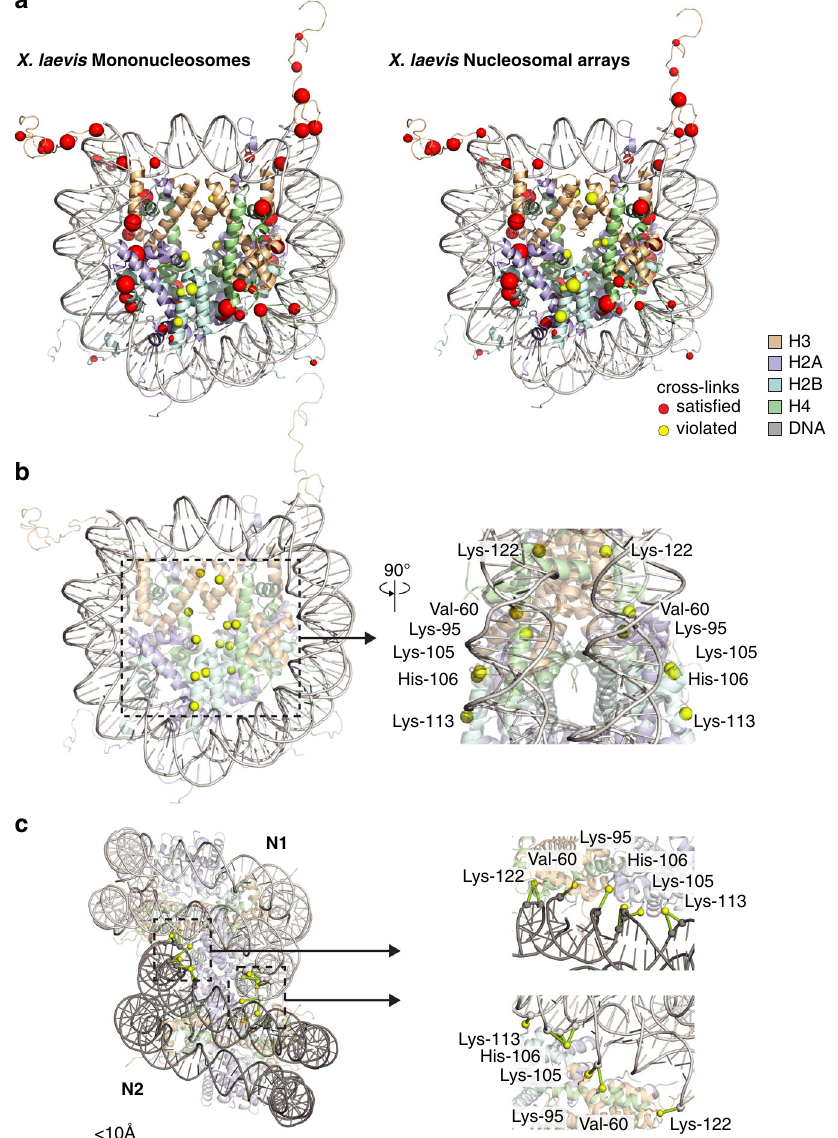
Fig. 2 Correlation of DNA and cross-liking sites. a Nucleosome core particle structure (pdb 1KX5) with cross-linked amino acids (C ɑ ) in X. laevis mononucleosomes or nucleosomal arrays highlighted as red or yellow spheres, representing cross-linking site that satisfy or violate distance restraints, respectively. The sphere scale is determined by the CSM count-rank of the cross-linked amino acid. b NCP structure as in a . Cross-links violating distance restraints are highlighted in yellow. Right panel, zoomed side view of the NCP and indicated cross-linked residues. c Model of the tetranucleosome (46) full- fi lling distance restraints for H2A Lys-95, H2B Lys-105, His-106 and Lys-113, H3 Lys-122, and H4 Val-60. Right panel, zoomed view of violated cross- links in the tetranucleosome. N1-nucleosome 1; N2-nucleosome